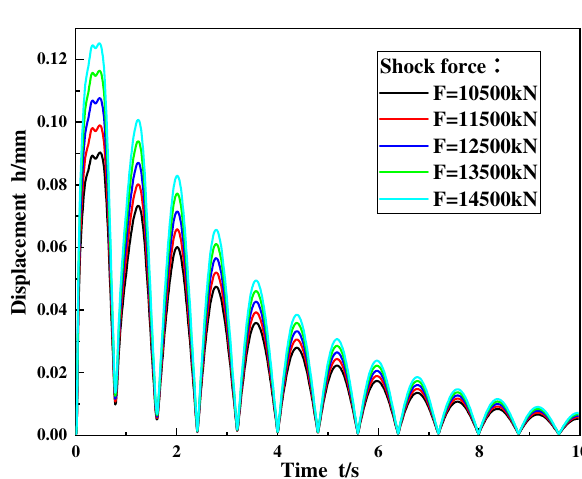
Figure 5. Displacement curve of foundation node under different shock